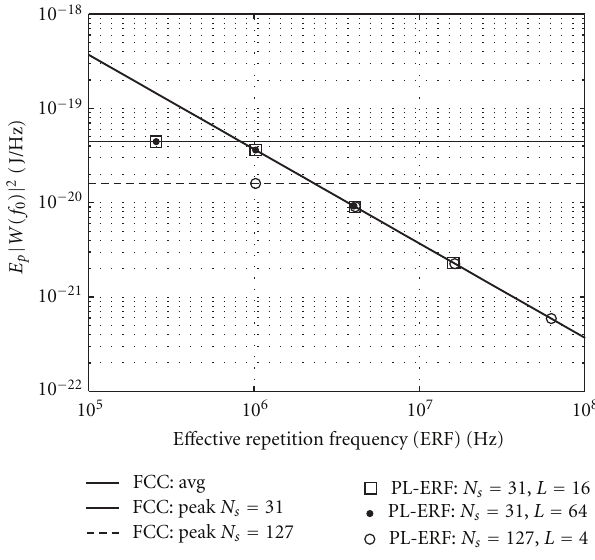
Figure 4: Pulse energy spectral density. 1 /B pk = 20ns are added. The ESD E p , p | W ( f c ) | 2 for the